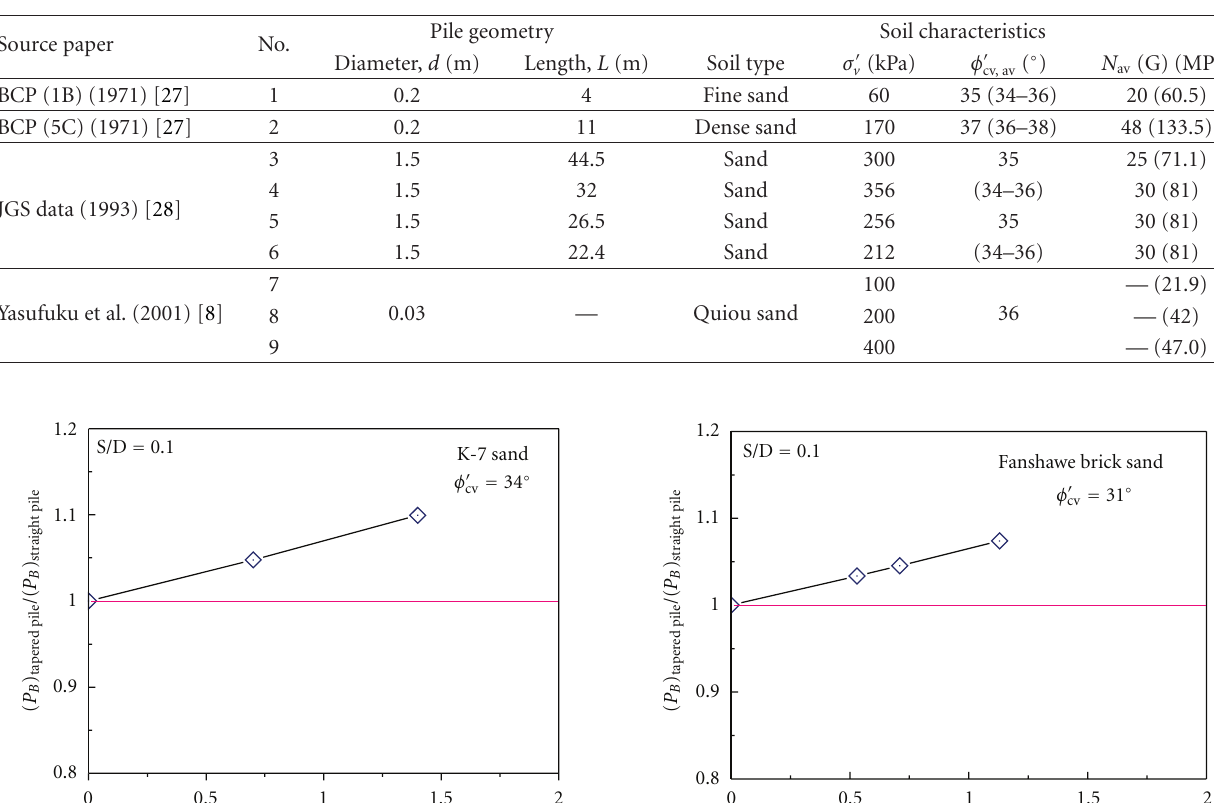
Table 3: Pile geometry and soil characteristics from di ff erent source papers.